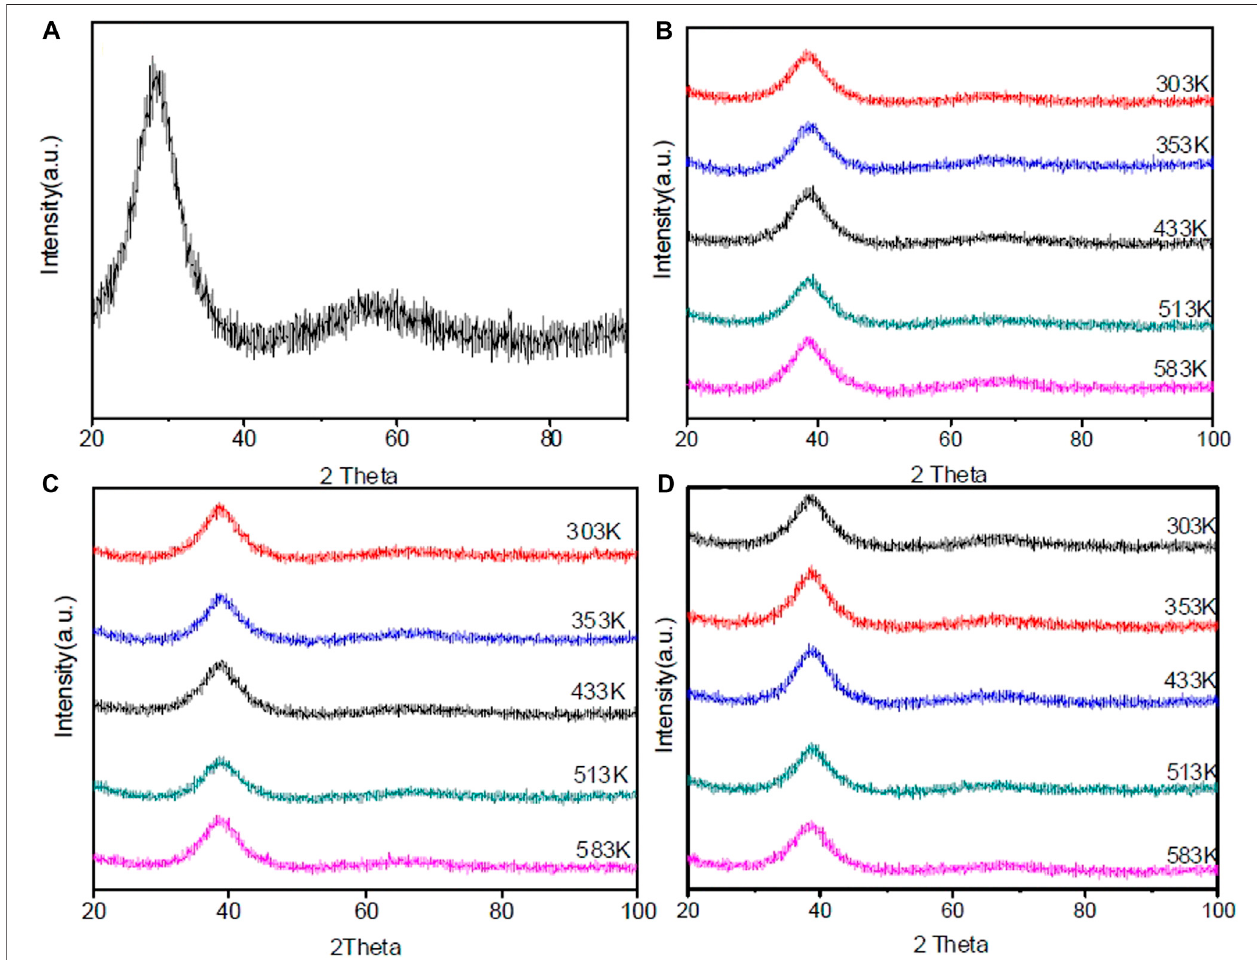
FIGURE 1 | (A) The XRD patterns of the as-cast Ti-based BMG sample and the samples tested at different temperatures with an applied load of (B) 1.5 N, (C) 2.5 N, and (D) 3.5 N.